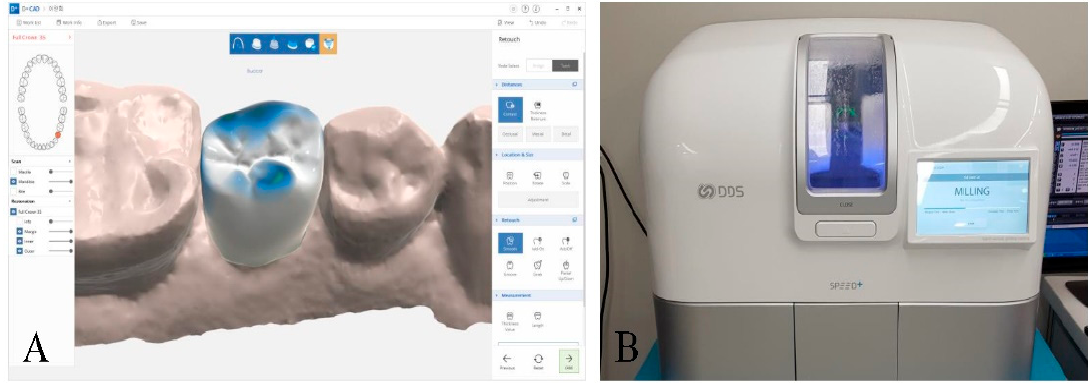
Figure 4. Chairside CAD / CAM procedures. ( A ) Planning a chairside crown with the design software. ( B ) Manufacturing a lithium disilicate crown with the milling machine.